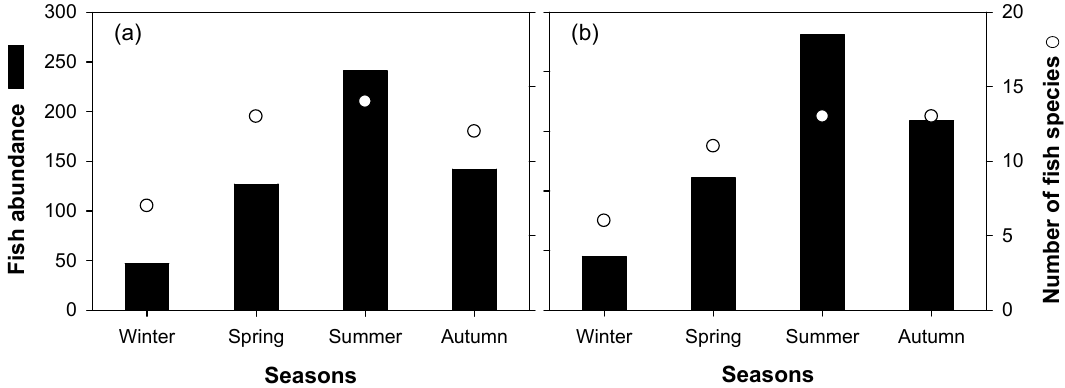
Figure 7. Seasonal abundance and number of fish species collected from sites 1 ( a ) and 3 ( b ).